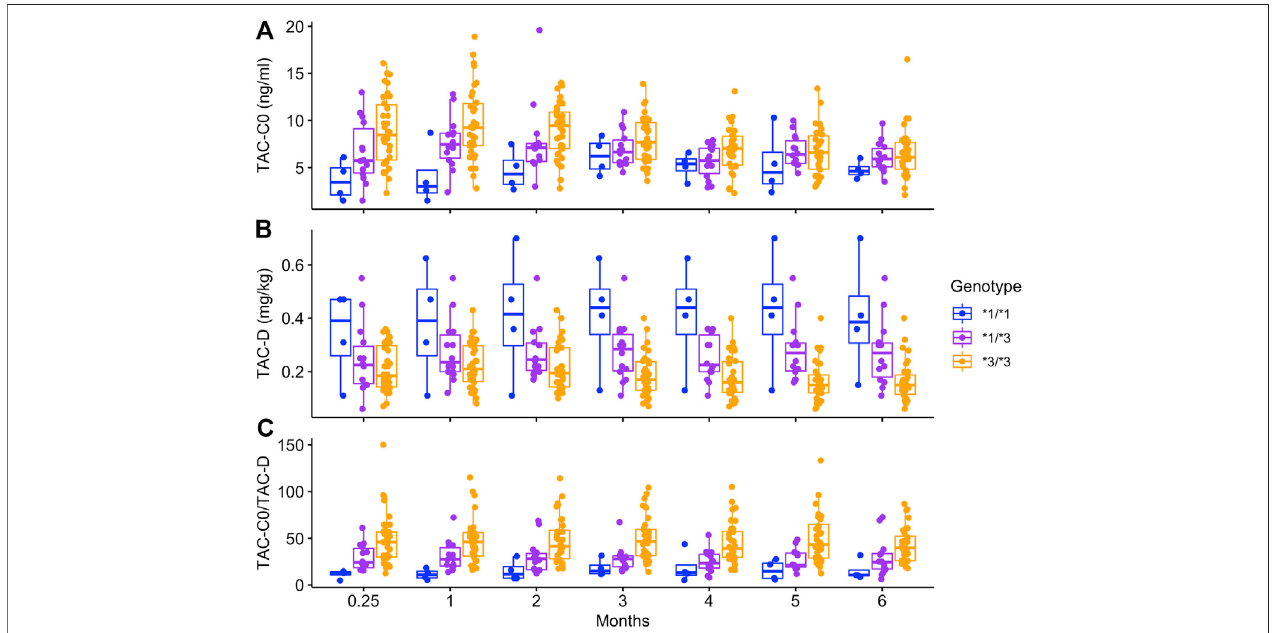
FIGURE 3 | Trough levels (TAC-C 0 ng/ml), dose requirements (TAC-D mg/kg) and trough levels normalized by dose requirements (TAC-C 0 /D ng*kg/ml/mg) in 52 patients with different CYP3A5 genotypes in TAC therapy that underwent a 6-month follow-up.